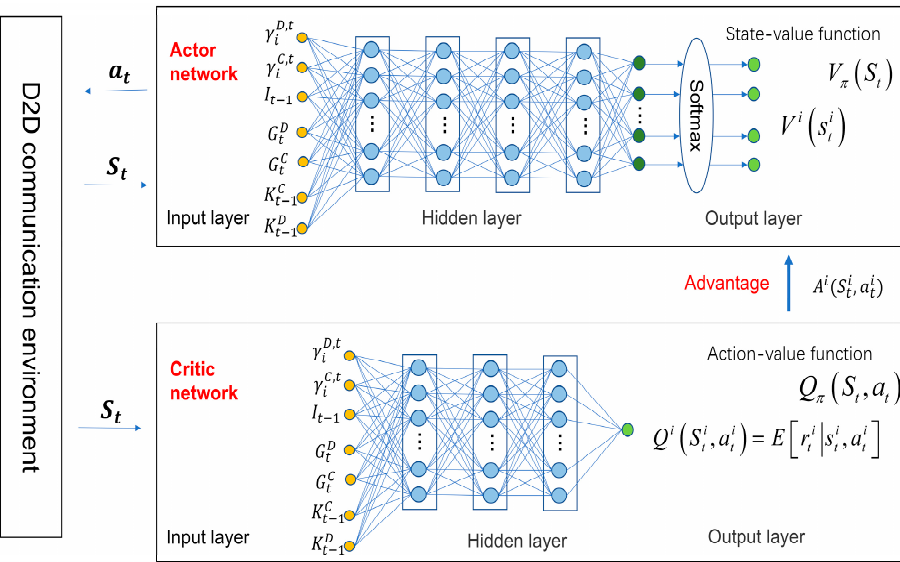
Figure 3. A2C communication model based on deep learning.